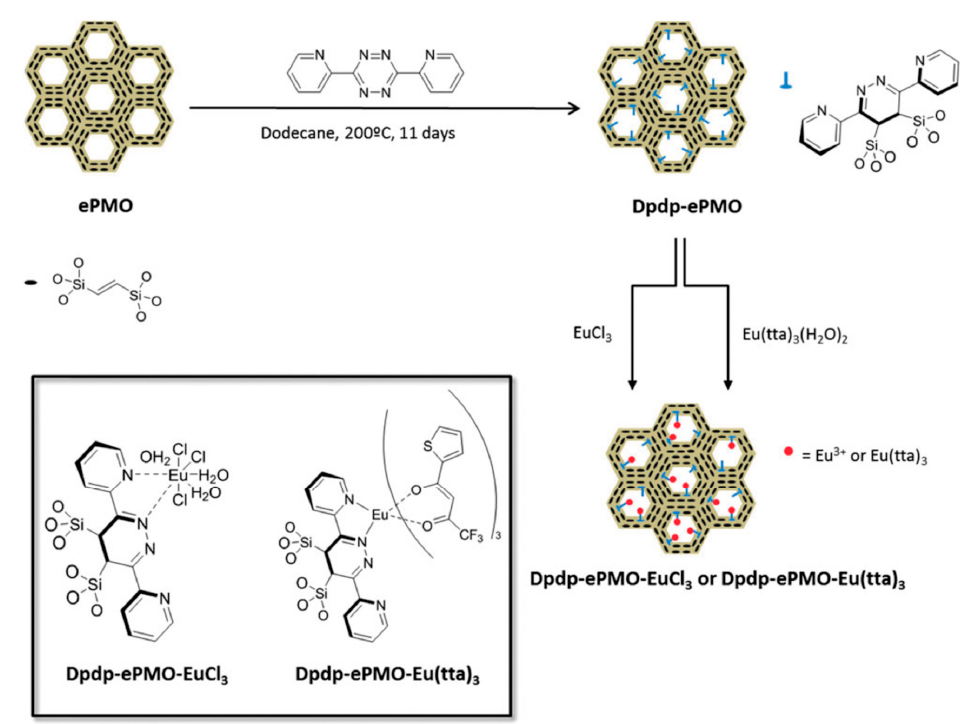
Figure 8. Schematic overview of the synthetic procedure for the formation of the surface Diels-Alder adducts on the ePMO and predicted structure of the resulting organic-inorganic luminescent hybrid mesoporous materials grafted with europium ions or complexes [47].